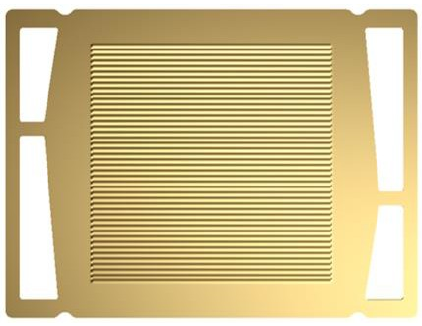
Figure 5. 3D model of a prototype of titan made bipolar plate. Reprinted with permission from Ref. [15] . 2022, Sebastian Melzer”.